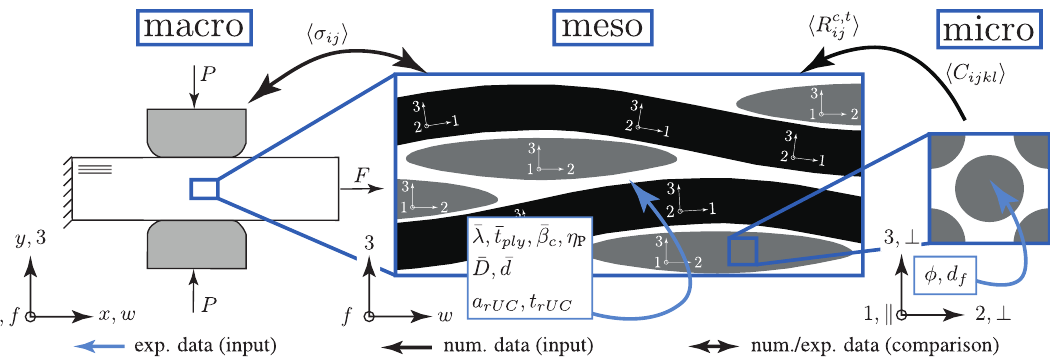
Figure 1. Schematic illustration of experimental and numerical multi-scale approach and notation of each used coordinate system.